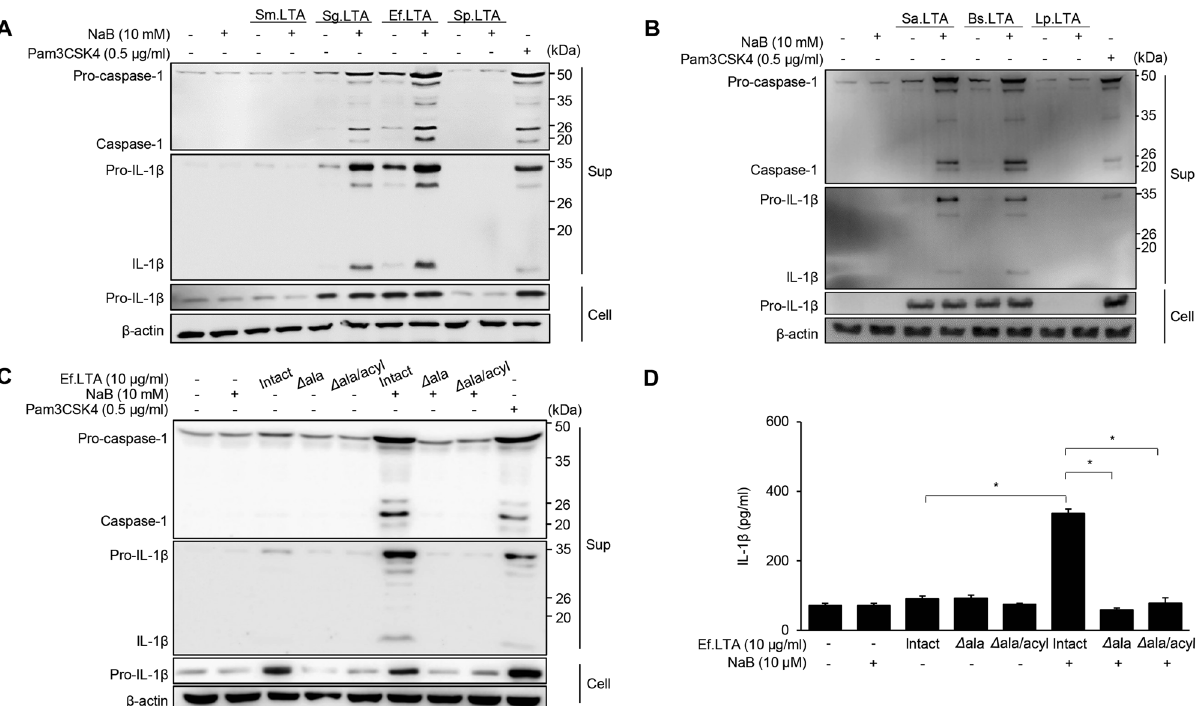
Fig. 2 D-alanine moieties of Ef.LTA are critical for in fl ammasome activation. A , B PMA-differentiated THP-1 cells were stimulated with 10 μ g/ml of LTAs puri fi ed from Streptococcus mutans (Sm.LTA), Streptococcus gordonii (Sg.LTA), E. faecalis (Ef.LTA), Streptococcus pneumoniae (Sp.LTA), Staphylococcus aureus (Sa.LTA), Bacillus subtilis (Bs.LTA) and Lactobacillus plantarum (Lp.LTA) or 0.5 μ g/ml of Pam3CSK4 in the presence or absence of NaB (10 mM) for 6 h. After the stimulation, the pro- or active forms of caspase-1 and IL-1 β in the culture supernatants (Sup) and pro-IL-1 β and β -actin in the cell lysates (Cell) were detected by immunoblotting. C , D PMA-differentiated THP-1 cells were stimulated with dealanylated ( Δ ala)-Ef.LTA and dealanylated/deacylated ( Δ ala/acyl)-Ef.LTA in the presence or absence of NaB for 6 h. C Pro- or active forms of caspase-1 and IL-1 β in the culture supernatants (Sup) and pro-IL-1 β and β -actin in the cell lysates (Cell) were detected by immunoblotting. D IL-1 β expression in the culture supernatants was measured by ELISA. Pam3CSK4 was used as a positive control. The results shown are representative of triplicate